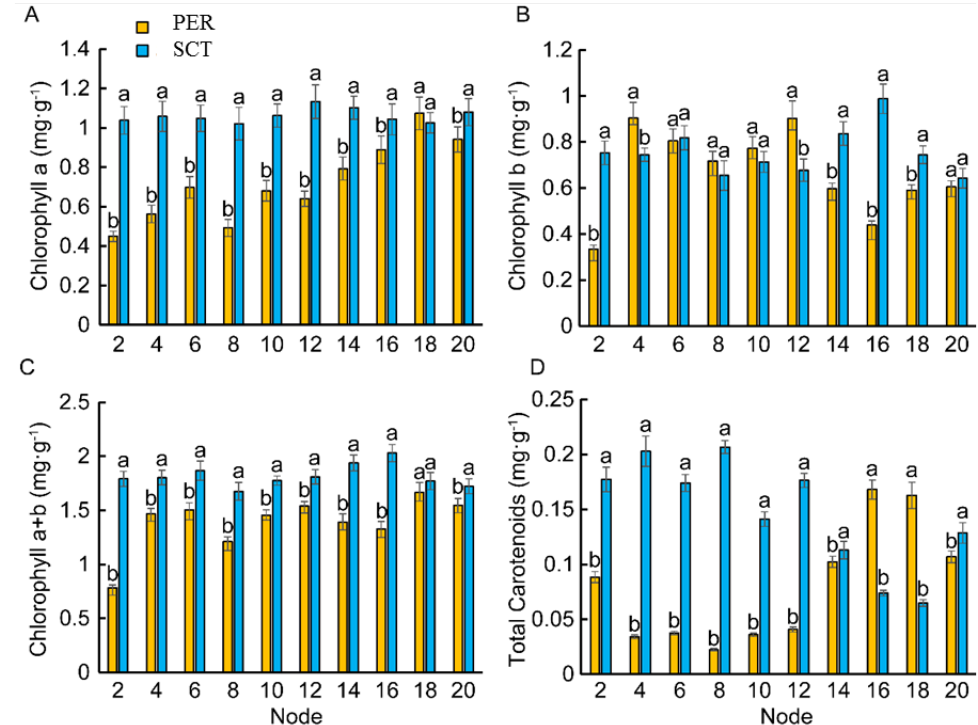
Figure 7. The chlorophyll and carotenoid content of leaves at different node positions with PER (pergola) and SCT (single-curtain training system) at veraison. ( A ) chlorophyll a content, ( B ) chlorophyll b content, ( C ) total chlorophyll content, ( D ) carotenoid content. Data are means ± SD from three independent replicates. Different letters indicate a significant difference at p < 0.05 as determined by Duncan’s multiple range test.